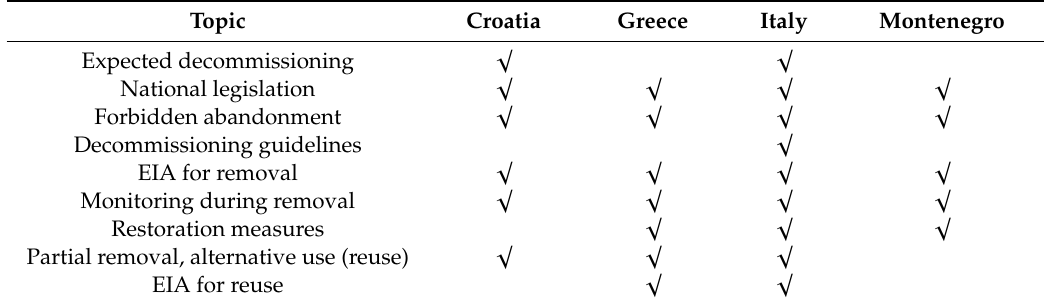
Table 3. Decommissioning: main topics considered at ADRION